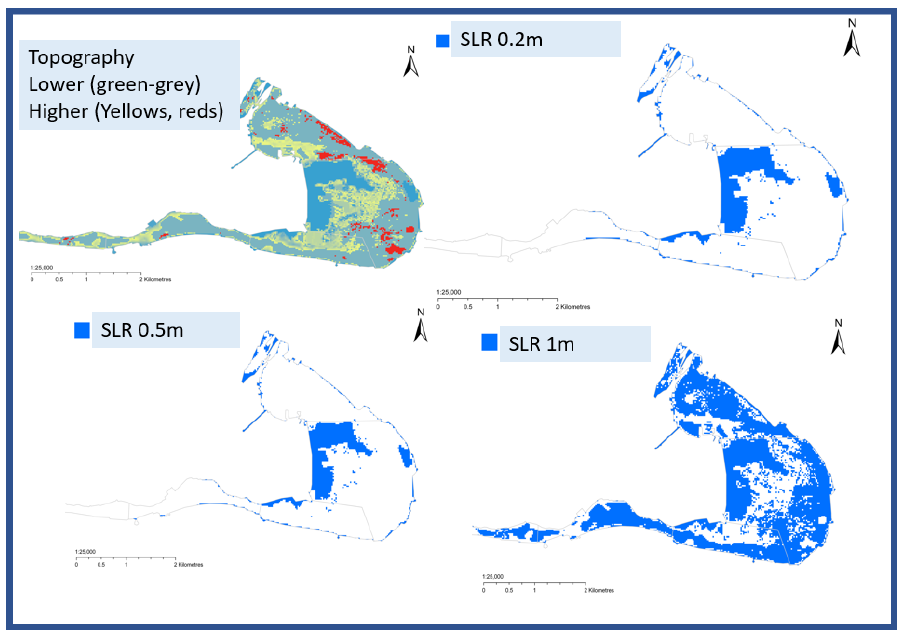
Figure 7. Geospatial maps of South Tarawa Atoll, Kiribati. Top left diagram is a visual representation of topography with gray-blue colors representing lower land elevations (c. 1 m or less above sea level) and red-yellow colors higher land elevations (highest elevation c. 3.5 m above sea level). The map in the top right and lower maps are simple ‘bathtub rise’ models indicating the flooded land at Sea Level Rises (SLRs) of 0.2, 0.5, and 1 m (corresponding to lower IPCC-RCP estimates of sea level rises in 2050 of 0.2 m and higher IPCC-RCP sea level rise estimates of 1 m by 2100). Models such as these, coupled with IPCC predictions, suggest that South Tarawa and similar ocean atolls should plan for a range of scenarios that address environmental change in the coming decades [29].